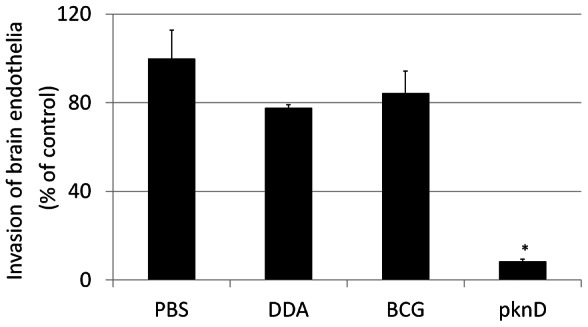
Pre-incubation of M.
tuberculosis with sera from PknD-vaccinated guinea pigs reduces invasion of brain microvascular endothelia:Human brain microvascular endothelia are the primary components of the blood-brain barrier and protect the CNS from the systemic circulation. Brain microvascular endothelial invasion of M. tuberculosis pre-incubated with sera from each vaccinated group normalized to the unvaccinated animals (PBS) is shown. While sera from the BCG vaccinated animals was not protective, pre-incubation of M. tuberculosis with sera from PknD-vaccinated guinea pigs significantly reduced (>10 fold) invasion of brain microvascular endothelia (P<0.01). Sera from three animals from each group were tested. Each assay was performed in triplicate. Data are presented on a linear scale as mean±standard deviation.